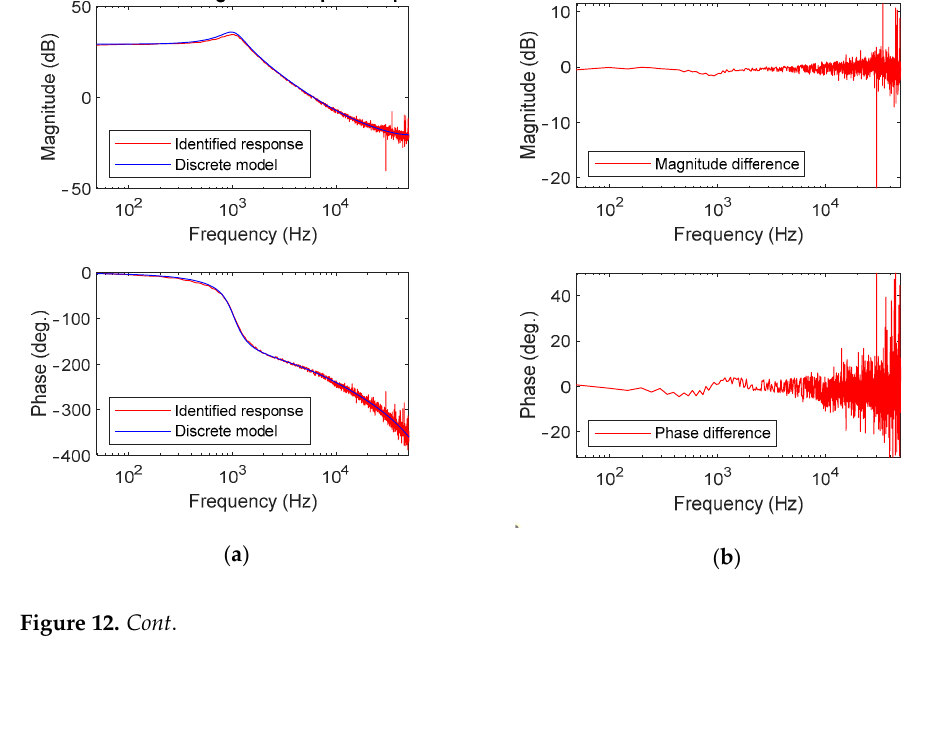
( d ) Figure 12. Boost converter open-loop results. ( a ) Bode plot without smoothing process. ( b ) Difference between discrete theoretical model and experimental measurements without smoothing process. ( c ) Bode plot with smoothing process. ( d ) Difference between model and measurement with the smoothing process. Finally, the identification results of Buck 1 (Table 1) working closed loop are shown in Figure 13 for the same perturbation than in the previous case. A PID compensator is tuned to achieve a cross-over frequency (cid:1858) (cid:3030) = 3 kHz and a phase margin (cid:1842)(cid:1839) = 50º . The results corresponding to the power stage identification applying the smoothing process are shown. The magnitude difference is within ±0.5 dB and in phase within ±7 deg. These results confirm the remarkable accuracy of the identification even working in closed loop.